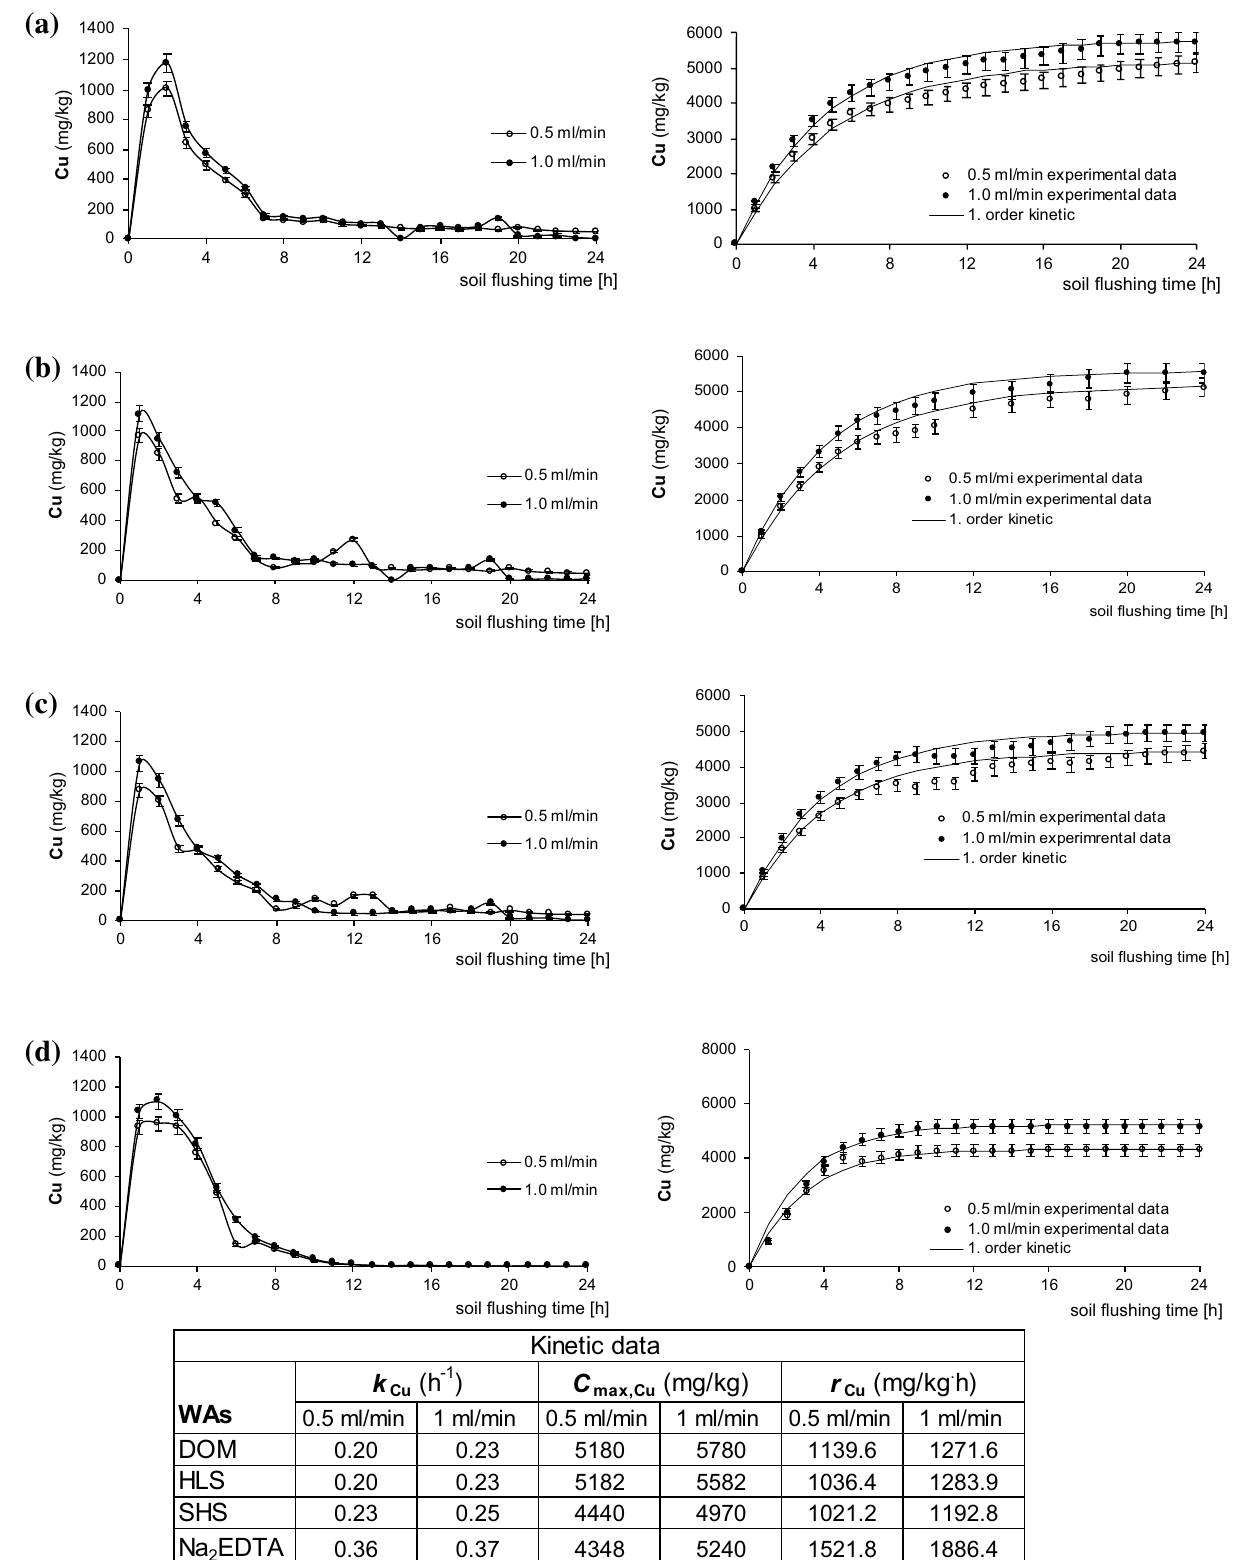
Figure 5. Cu mobilization curves and its cumulative removal during soil flushing at two flow rates with DOM ( a ), HLS ( b ), SHS ( c ), Na 2 EDTA ( d ) with kinetic constants. Data are expressed as mean values (n = 2) ± standard deviation error